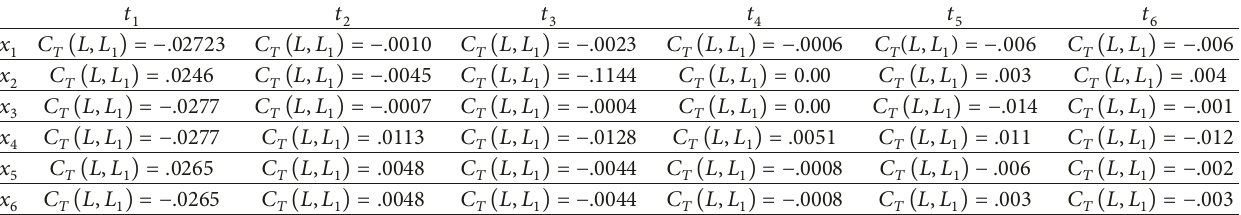
Table 20: Similarity measures 𝐶 𝑇 (𝐿,𝐿 1 )